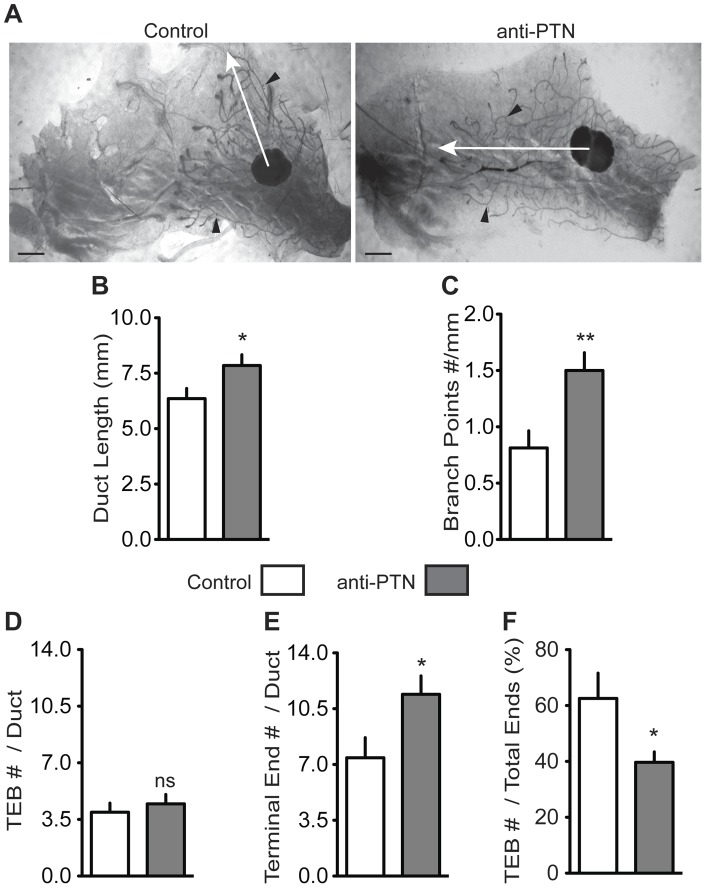
PTN effect on ductal outgrowth and branching in developing mammary glands.(A) Whole mounts of representative mammary glands from mice treated with anti-PTN blocking antibody versus control. White arrows: distance of the outgrowth of a representative duct measured from the midpoint of the lymph node. Black arrowheads: branch points. Scale bar  = 1.5 mm. (B to F) Controls (n = 9 mice, white), anti-PTN (n = 10 mice, grey). (B, C) Ductal length and number of branch points with the ductal length expressed in mm and the number of branch points per mm of duct. Data are means ± SE; *P = 0.04; ** P = 0.006; n = 3 ducts per mouse. (D to F) Quantitation of Terminal Ends (TE) and Terminal End Buds (TEBs) of mammary ducts; (D) TEBs per duct, ns =  not significant; (E) TEs per duct, * P = 0.03; (F) TEBs per total number of duct ends ( = TEBs + TEs), *P = 0.027. Data are means ± SE; n = 6 ducts per mouse.